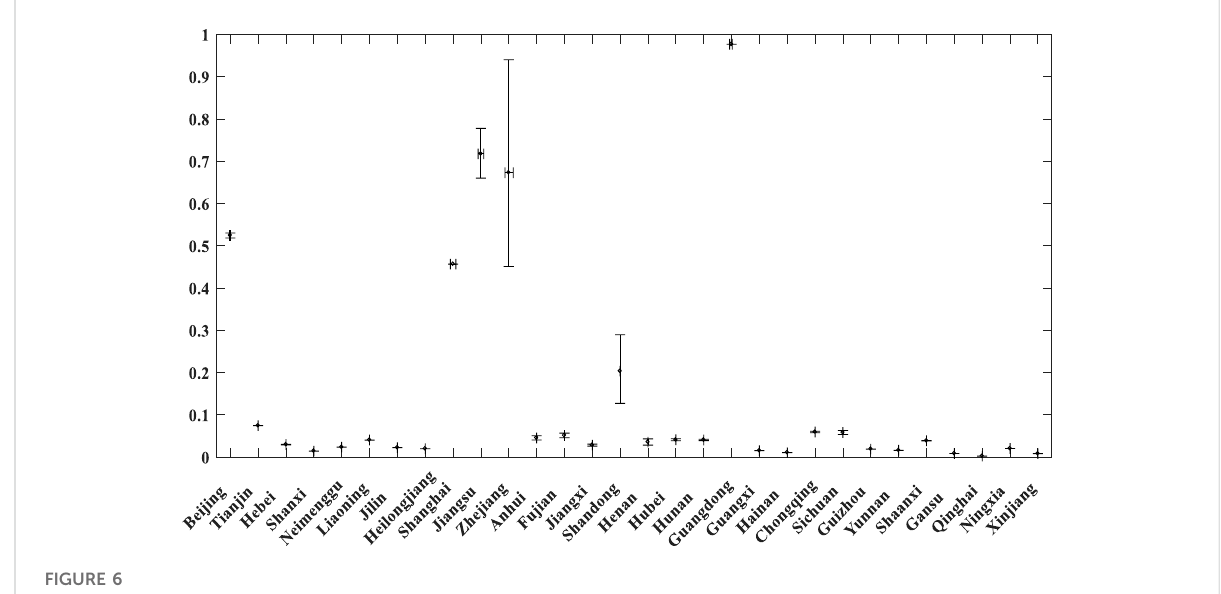
FIGURE 6 Prediction of KGM range for technology and fi nance by regions.